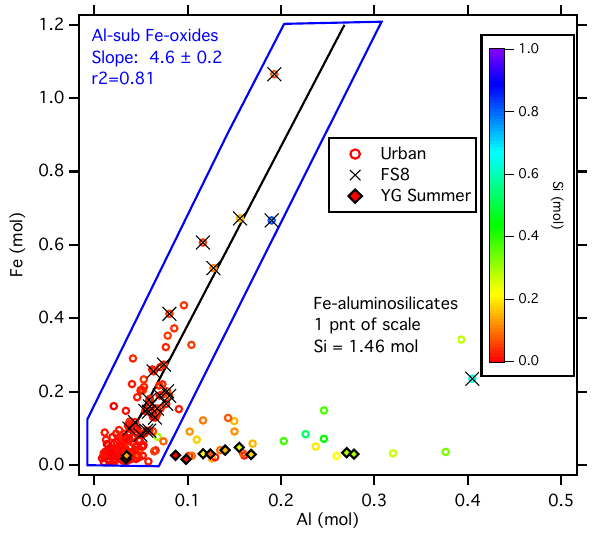
Fig. 5. Scatter plot of iron and aluminum molar concentration in iron-containing particles identified on urban and rural filters. The color scale denotes the silicon content in the particles. The blue outline represents single particles that are Al-substituted Fe-oxides. Particles from urban are represented by open colored circles. Parti- cles from Fort Yargo summer and Fire Station 8 sites are represented by colored diamonds and black Xs,